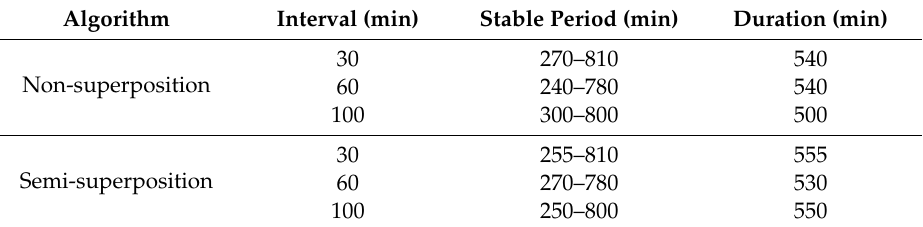
Table 3. The estimation of data-segmentation with a stable power input of TRT No.